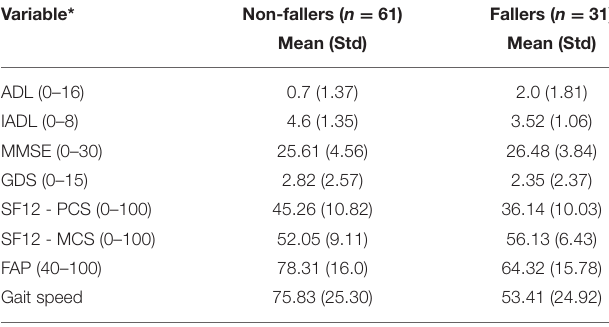
TABLE 2 | Predictor data characteristics.